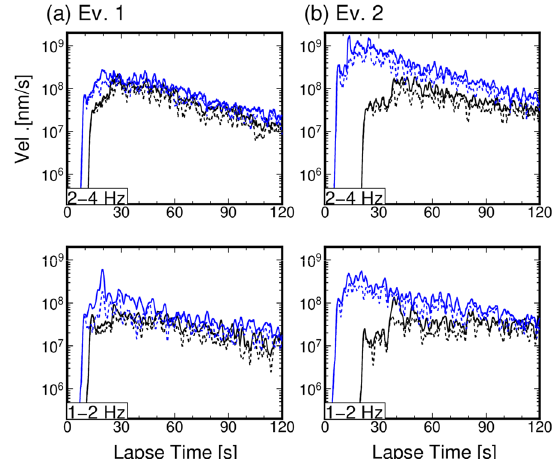
Fig. 7 Simulated horizontal (solid lines) and vertical (dotted lines) envelopes for frequency ranges of 1.0–2.0 Hz and 2.0–4.0 Hz for Model 0. The envelopes for a Event 1 and b Event 2. The blue and black lines denote envelopes at M.KMB06 and N.KISF stations,